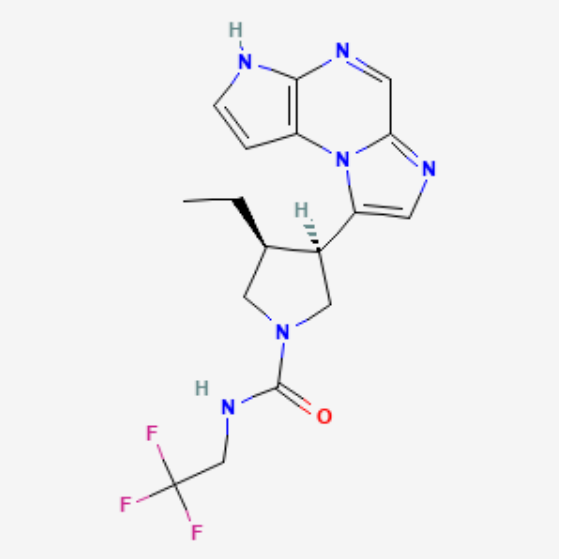
Figure 1. Chemical structure of upadacitinib. Available at [14], Reproduce with permission from the National Library of Medicine.